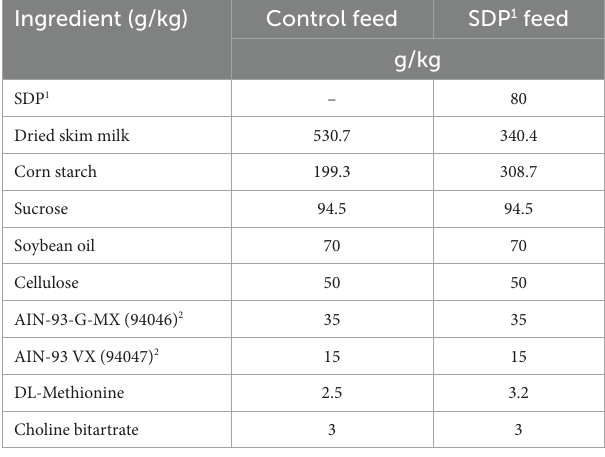
TABLE 1 Composition of experimental